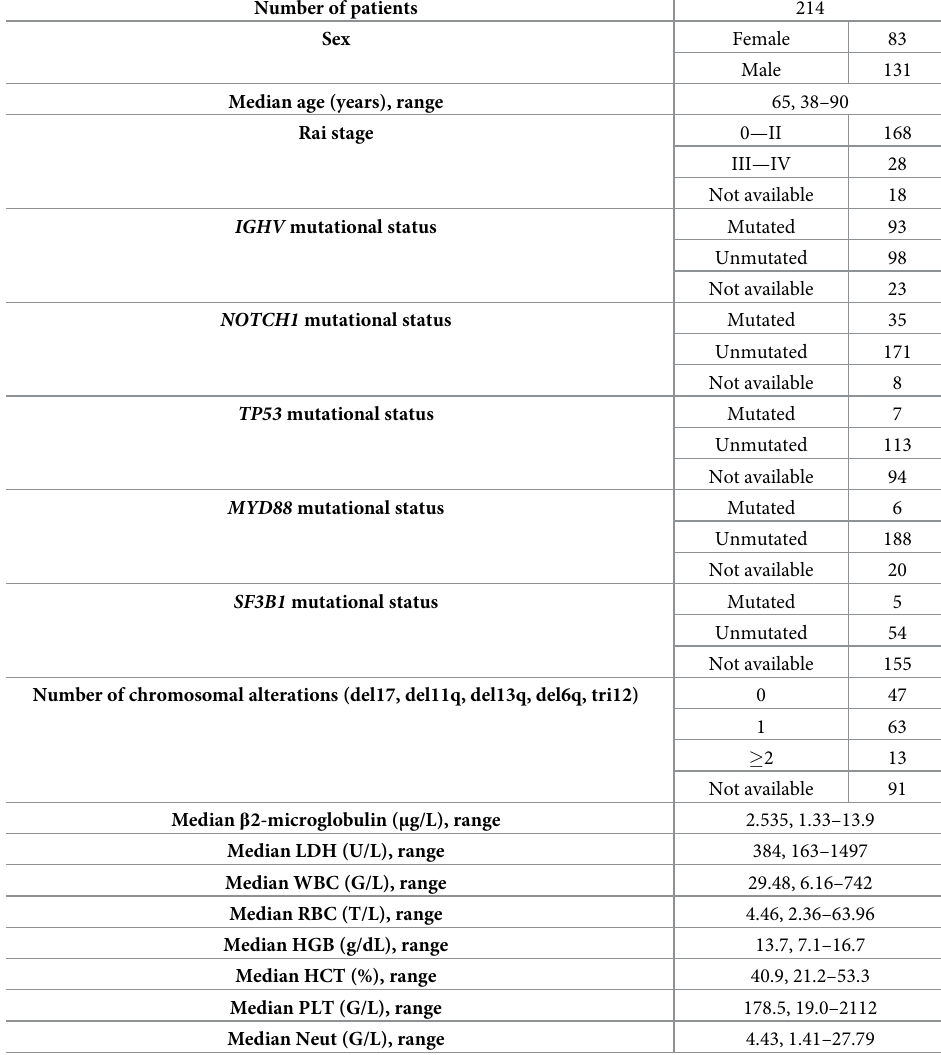
Table 1. Clinical characteristics of CLL